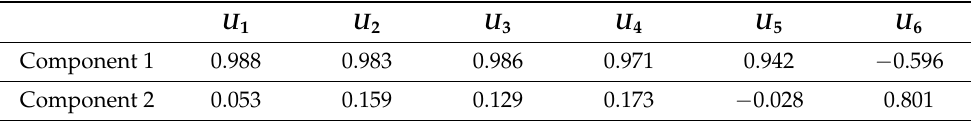
Table 3. The principal component variable component matrix.